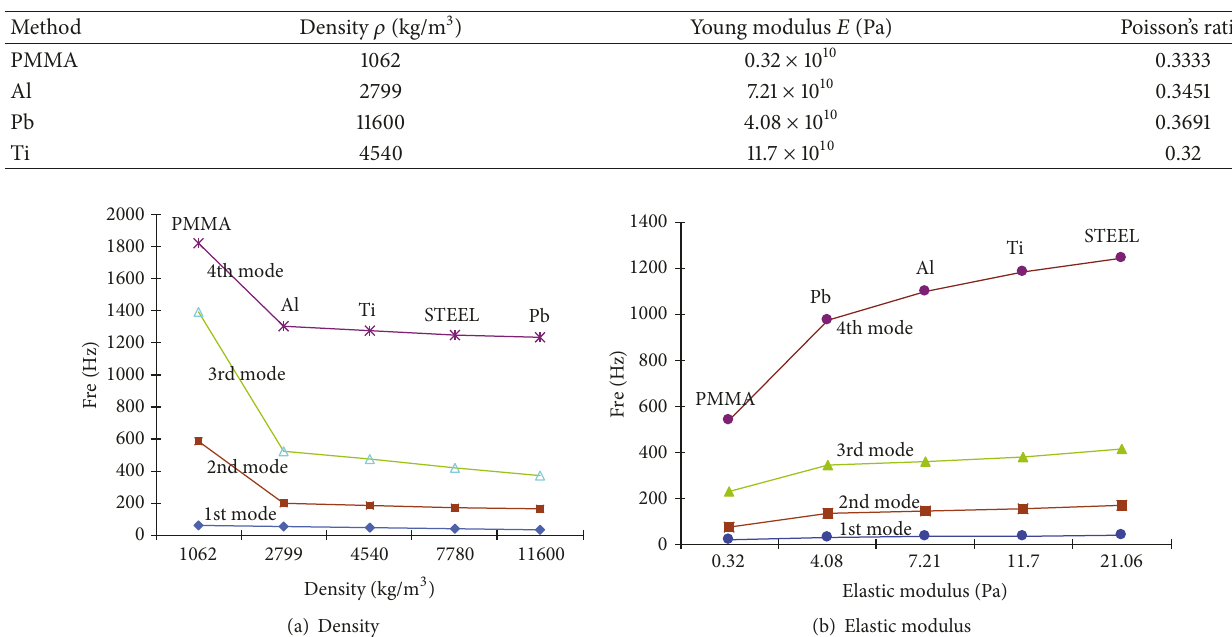
Table 4: Material parameters.